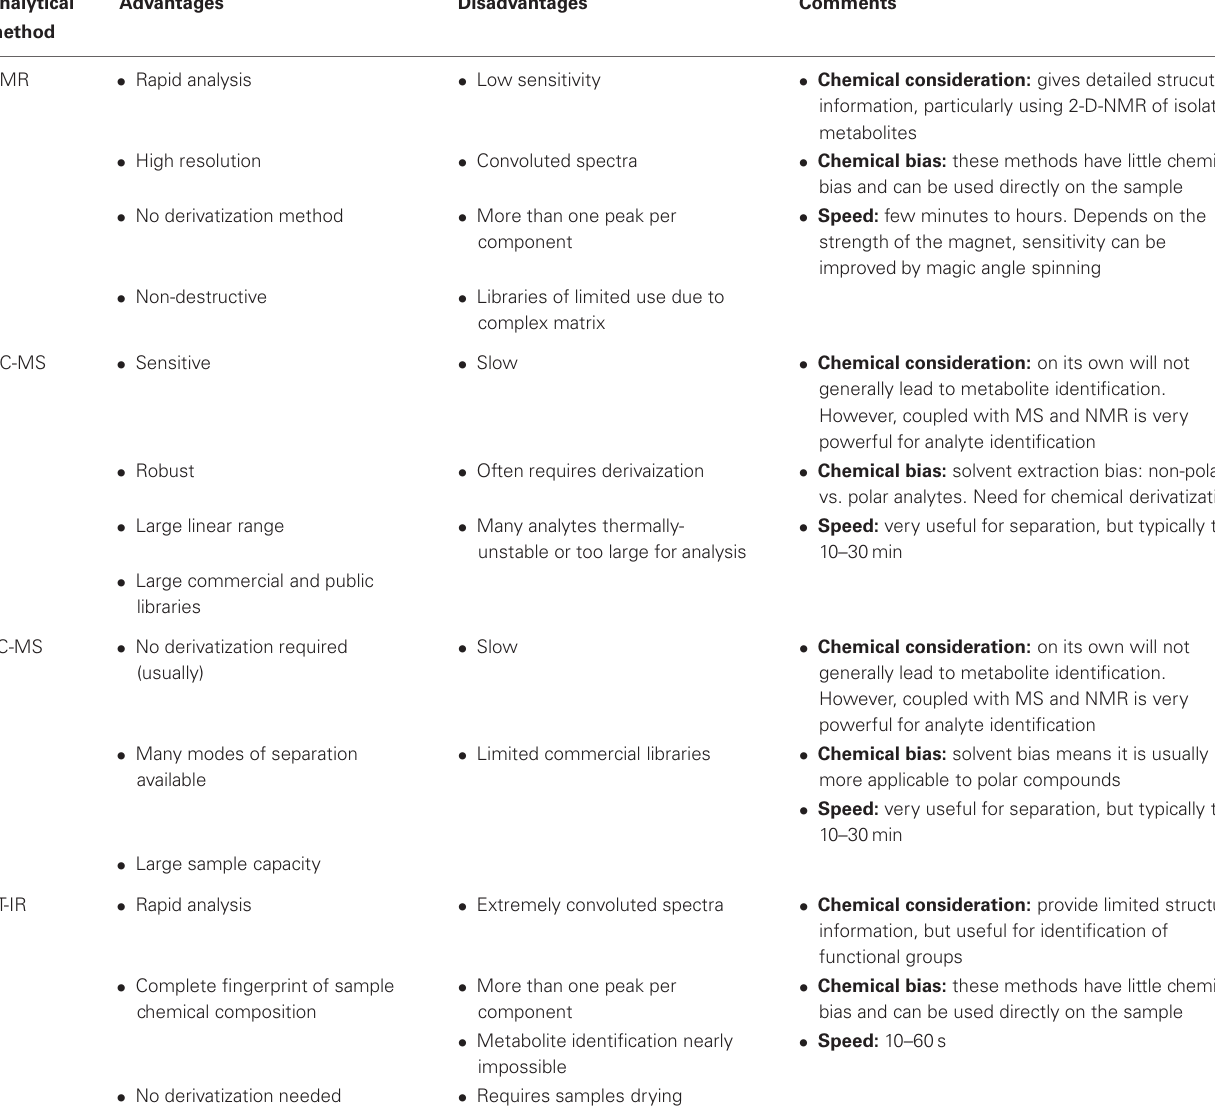
Table 1 | Common analytical techniques used in